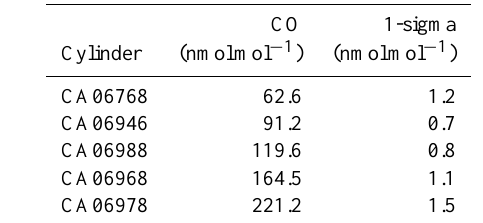
Table 1. WMO CO standard gases of the Iza˜na station: CO mole fraction and standard uncertainty referenced to the WMO-2004 CO scale. The mole fractions were assigned by the WMO CO CCL in